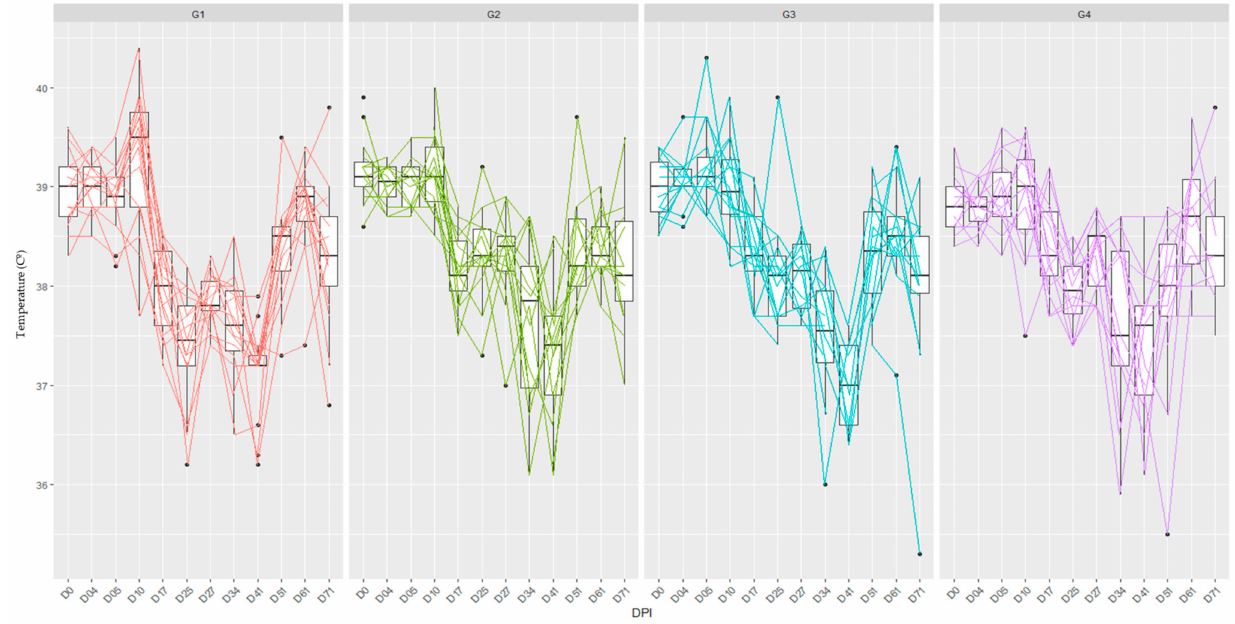
Figure 1. Parallel coordinate boxplots of rectal temperature measurements ( ◦ C) recorded over time considering animals from G1 to G4. The lines in a parallel coordinates plot represent the trajectories of observations across different time points. The bold dots indicate the